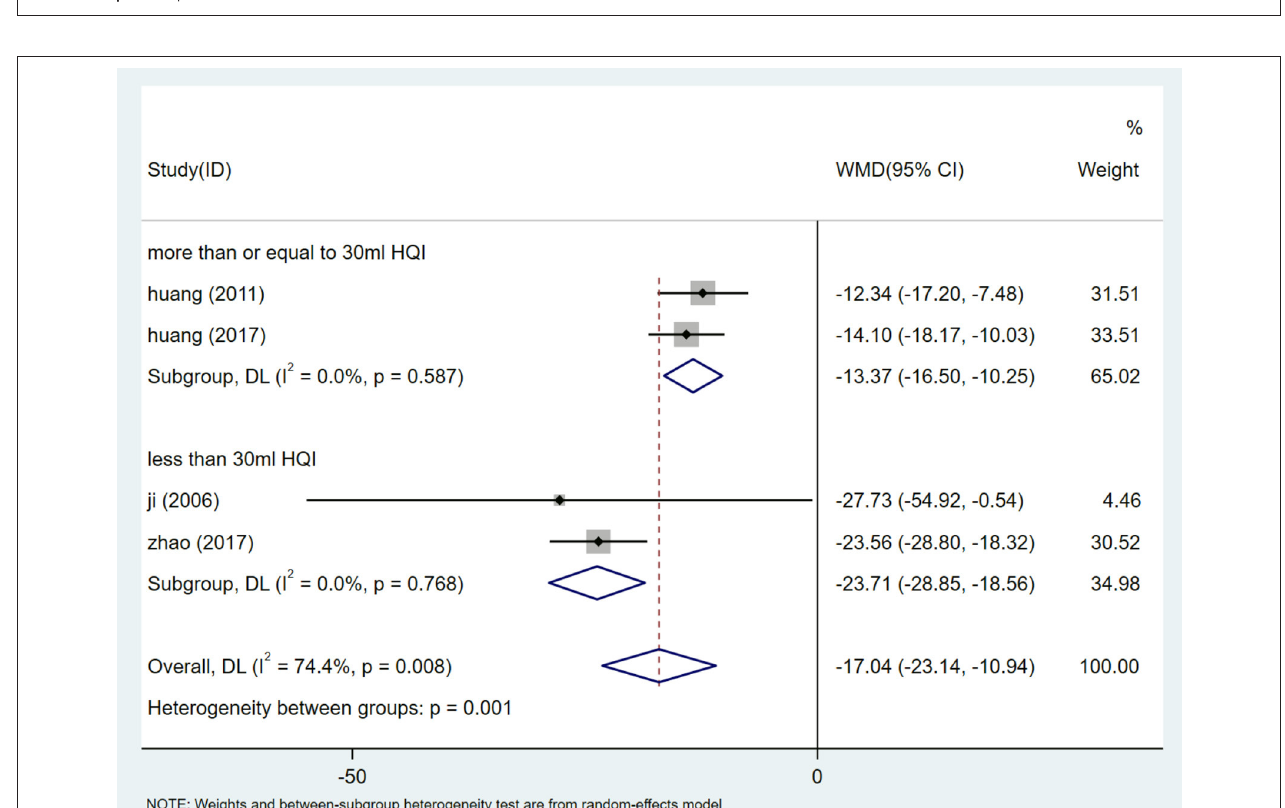
FIGURE 6 | Subgroups analysis of mALB.